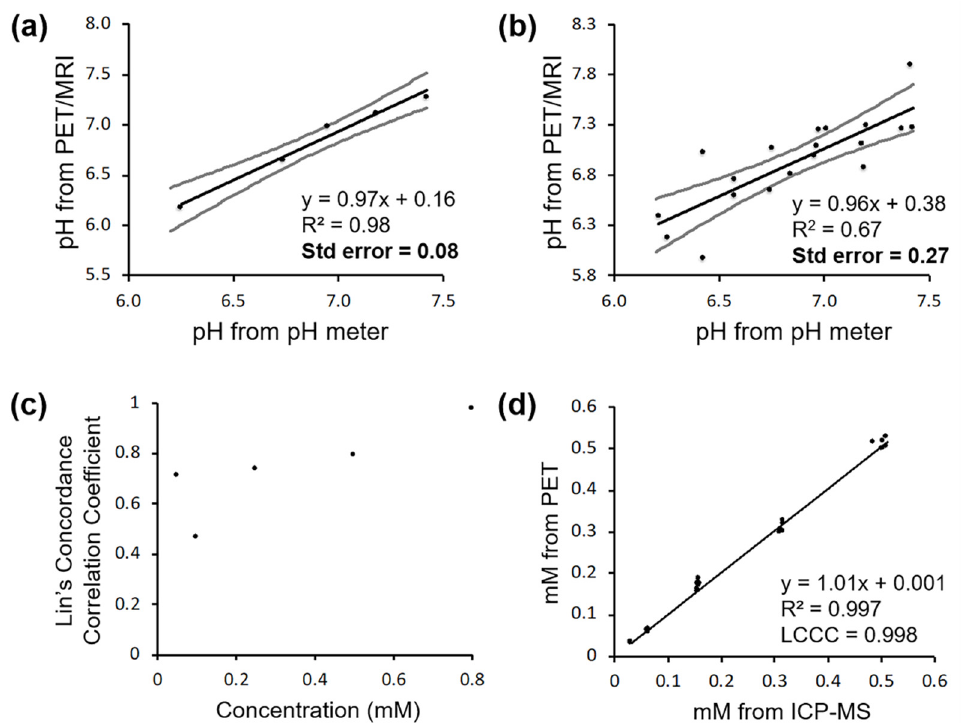
Figure 3. PET/MRI co-agents can measure pH in solution. ( a ) pH measured by a calibrated pH meter versus pH measured by PET/MRI in samples at a 0.8 mM concentration of MRI co-agent gives a standard error of 0.08 pH units. ( b ) pH measured by a calibrated pH meter versus pH measured by PET/MRI in samples including 0.8, 0.5, and 0.25 mM concentrations of MRI co-agent gives a standard error of 0.27 pH units. ( c ) Lin’s Concordance Correlation Coefficients were calculated for each set of samples at different MRI co-agent concentrations, and LCCCs improved as concentration increased. ( d ) MRI co-agent concentration measured by PET/MRI versus MRI co-agent concentration measured by ICP-MS shows high precision (R 2 = 0.997) and high accuracy (LCCC = 0.998).